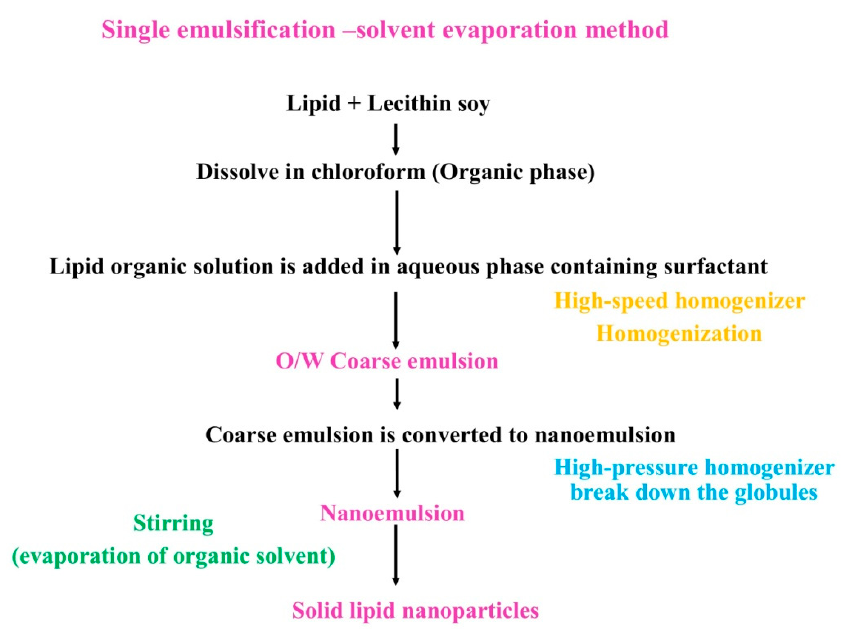
Figure 4. Flow chart for solvent emulsification/evaporation method.